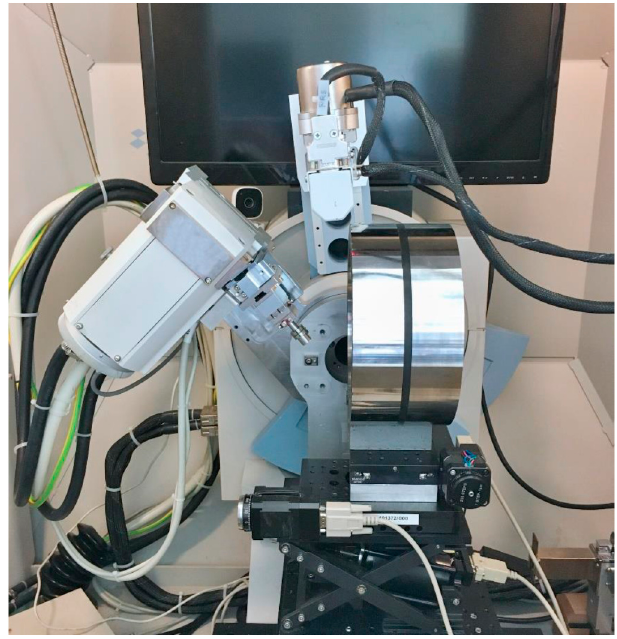
Figure 3. Sample when analyzing the inner surface.